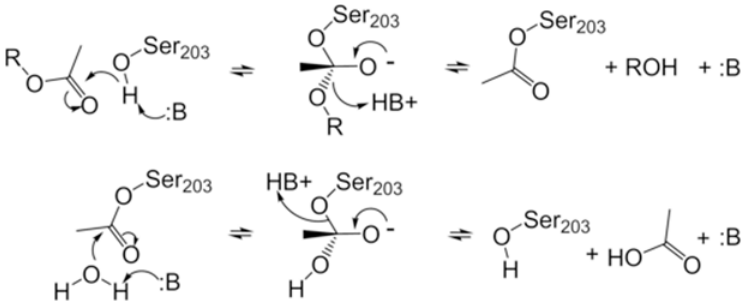
Fig 1. Acylation mechanism of hAChE by acetylcholine. The nucleophilic attack of the deprotonated Ser203 hydroxy group on the carbonyl carbon of acetylcholine and the reactivation of Ser203 by an activated water is shown.